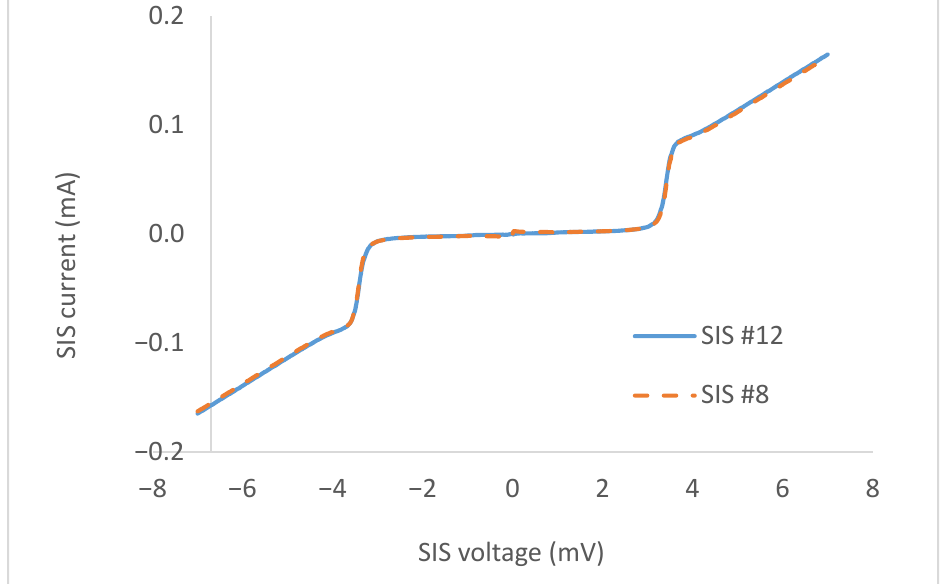
Figure 8. I–V characteristics of Nb–AlN–NbN junctions of the same size, fabricated using EBL and plasma chemical etching in a CF 4 atmosphere, located on different parts of the same substrate: SIS #8 with an area of 0.480 µm 2 with a current density of 15 kA/cm 2 , R n = 40.98 Ω , R j / R n = 18.4, V g = 3.39 mV; SIS #12 with an area of 0.488 µm 2 with a current density of 15 kA/cm 2 , R n = 40.34 Ω , R j / R n = 20.7, V g = 3.38 mV.